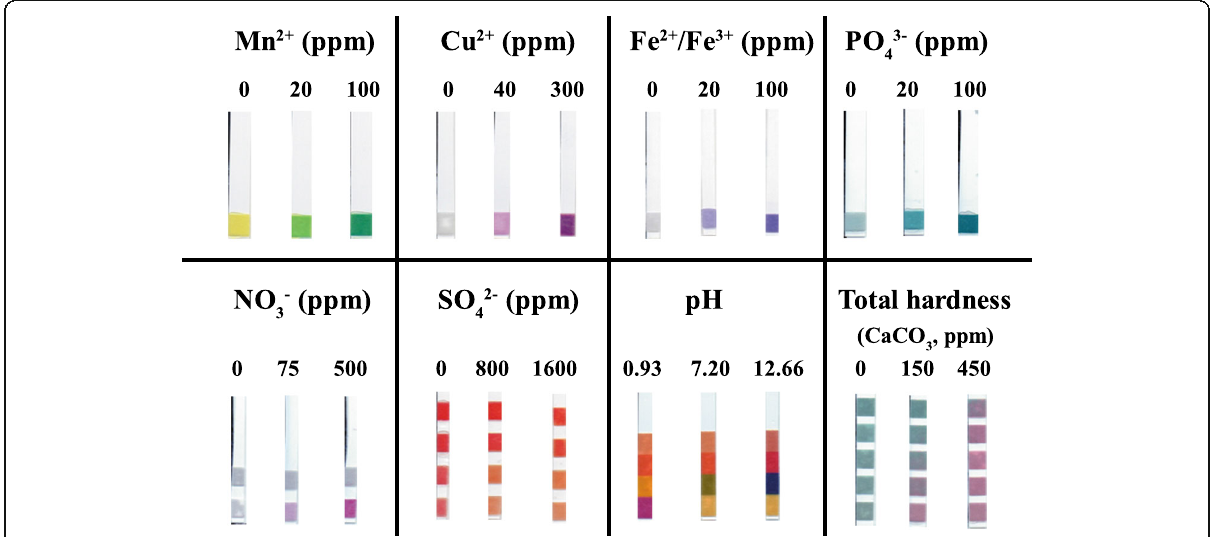
Fig. 2 Colorimetric sensors and sensor arrays after immersion in standard solutions at different concentrations. It was noted that only the first reactive zone that was used to measure NO 3- . The second zone was used to measure the concentration of nitrite ion (NO 2- ) which was not